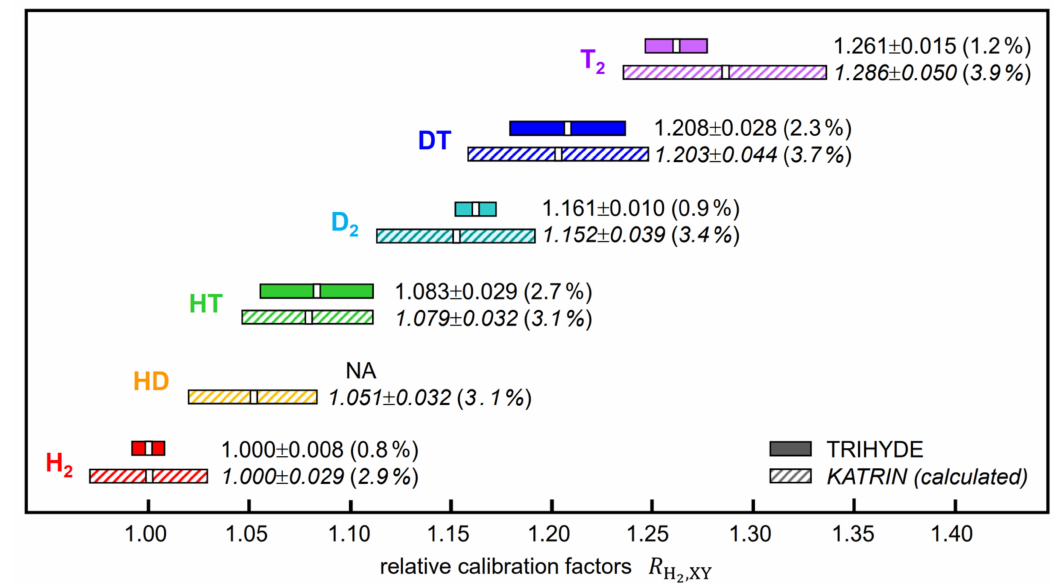
Figure 8. Calibration factor ratios, R H , with X, Y ∈ [H, D, T]; comparison between the experimental values derived in 2 ,XY this TRIHYDE work and the calculated (theoretical) values used in the KATRIN experiment, based on the data given in Refs.